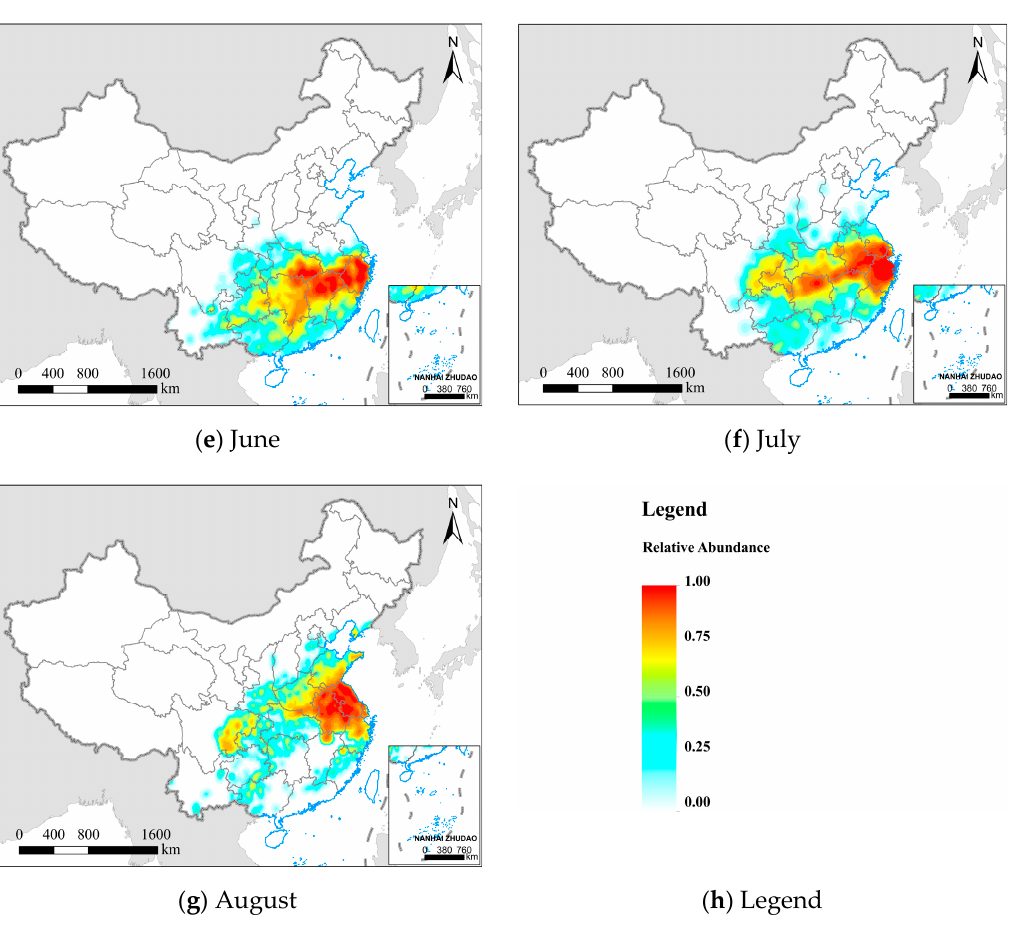
Figure 5. Spatial distribution and relative abundance of the FAW from February to August 2020. ( a – g ) represent different months, and ( h ) the legend from blue to red represents the relative abundance of FAW increasing.